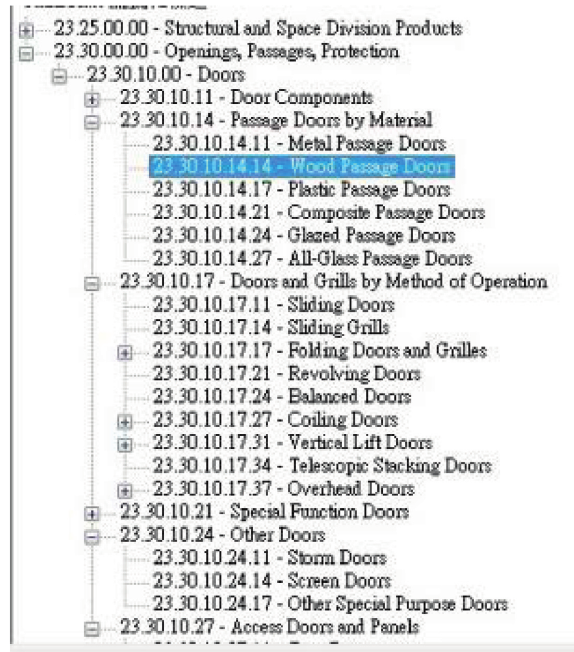
Figure 3: The door system coding in OmniClass (source: Autodesk Revit 2016) [20].